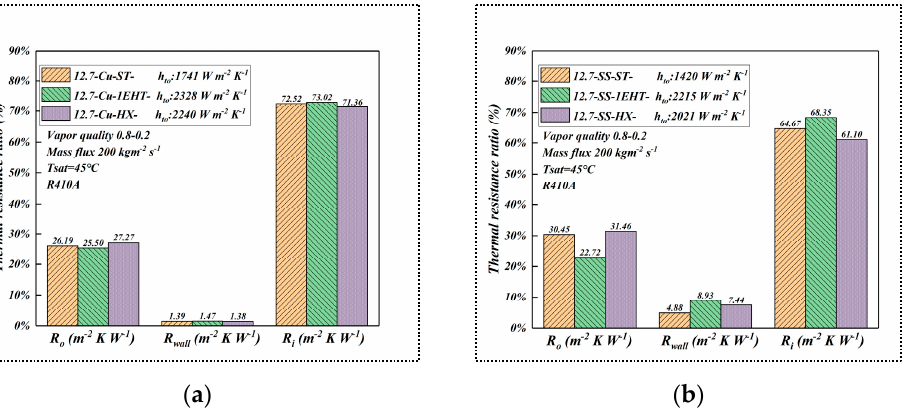
Figure 9. Comparison of condensation thermal resistance ratio of different tube materials ( a ) copper ( b ) SS.